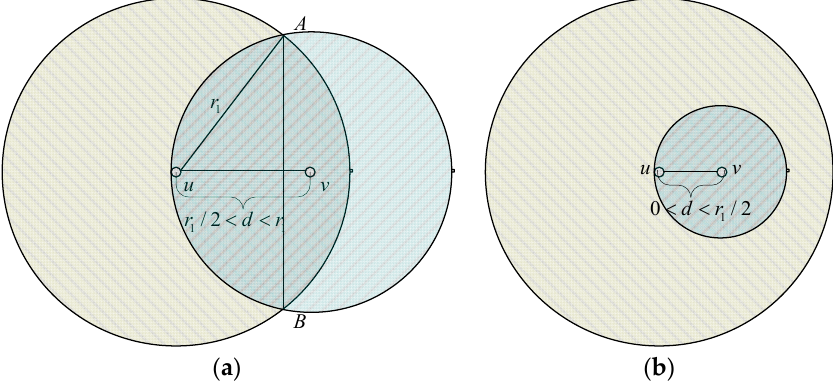
Figure 10. Different node positions in heterogeneous networks: ( a ) r /2 ≤ d ≤ r ; ( b ) 0 ≤ d ≤ r